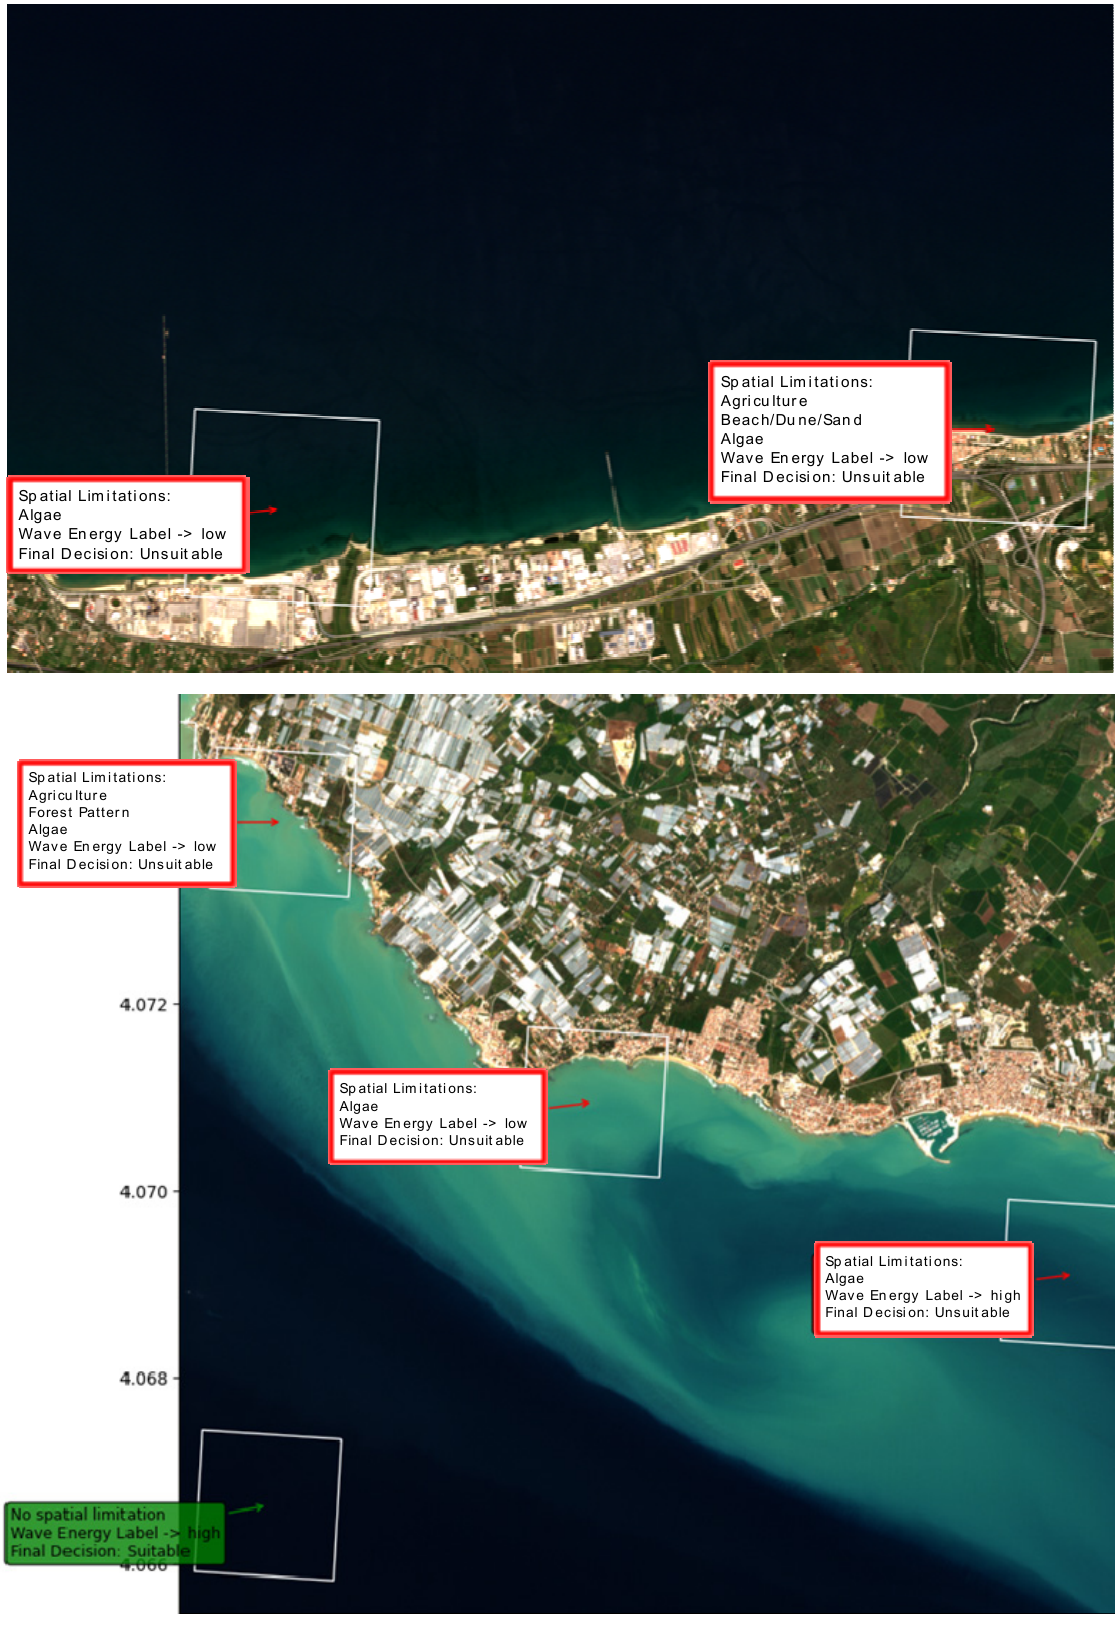
Figure 11. Multitask Data Fusion based Neural Network predictions on test dataset.